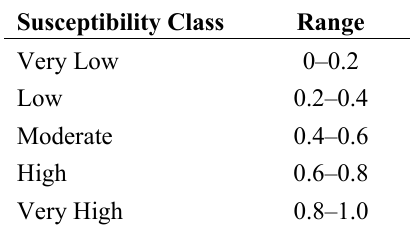
Table 4. Ranges adopted in the slicing process.